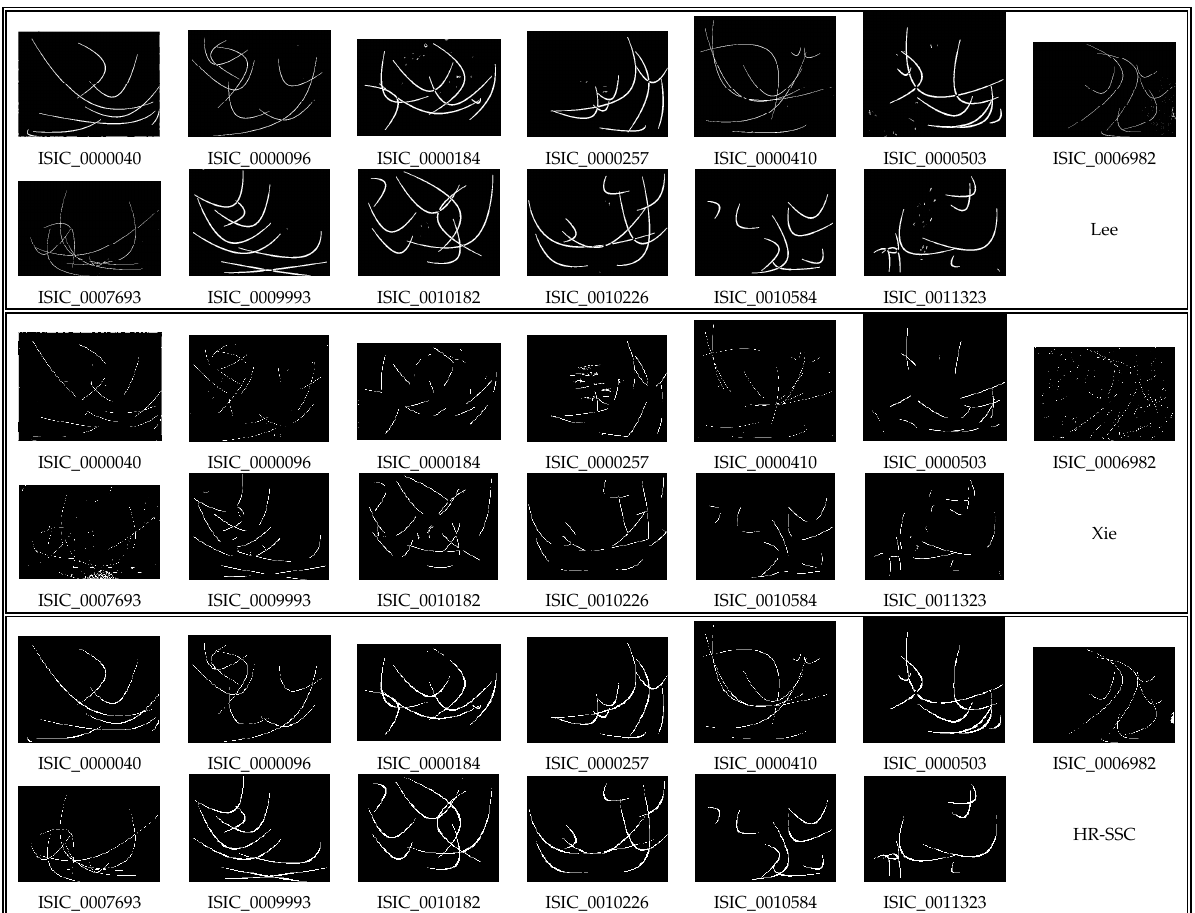
Figure 13. Resulting mask of HairSim method and the resulting mask of methods Lee, Xie, and HR-SSC on sHSim-data .